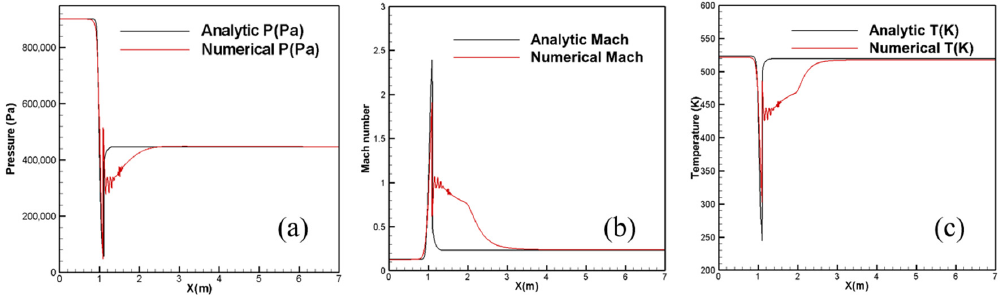
Figure 9. Spatial distributions of properties along pipe axis: ( a ) static pressure; ( b ) Mach number; ( c ) temperature.